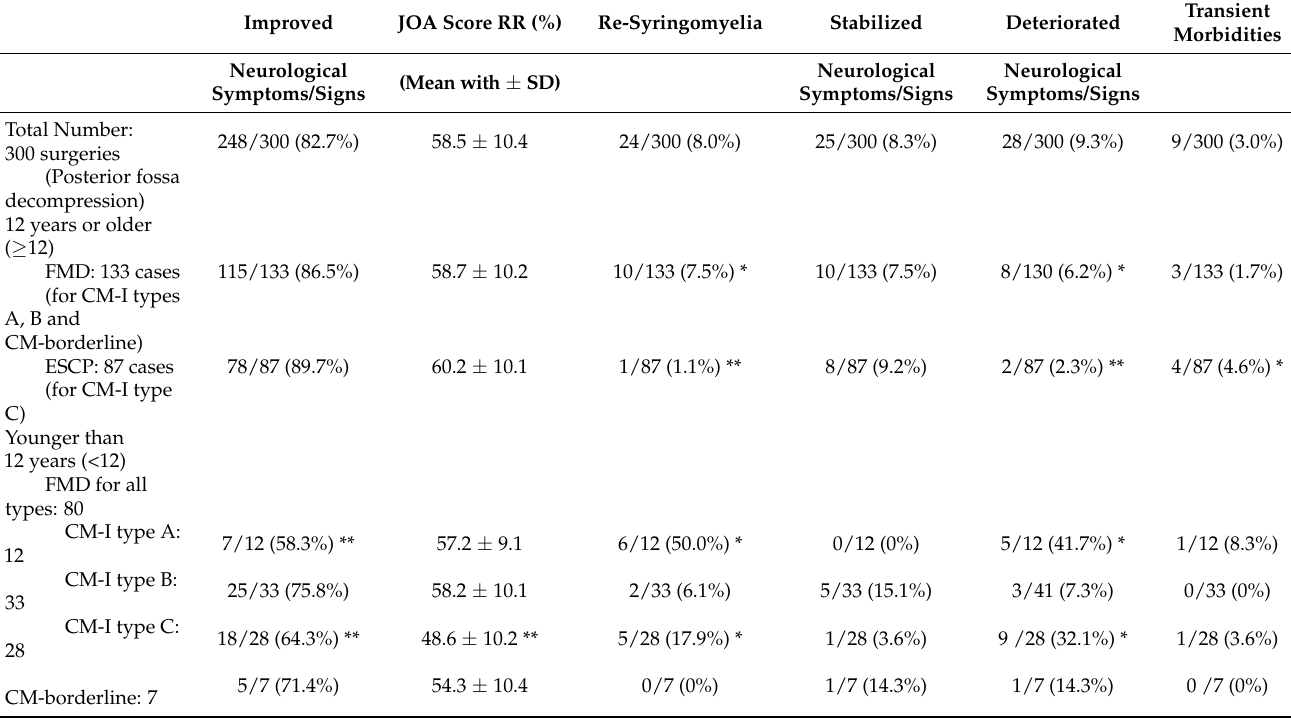
Table 4. JOA score RR after FMD and ESCP, and their